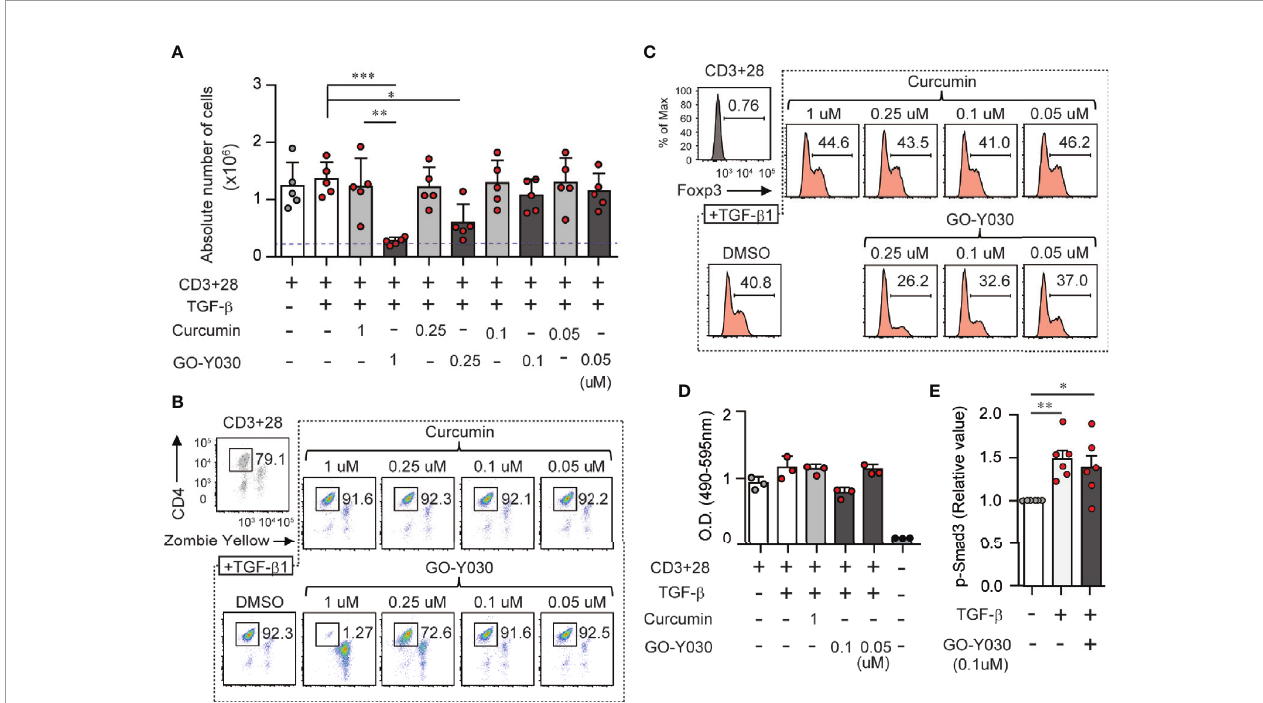
FIGURE 1 | GO-Y030 inhibits TGF- b -induced Foxp3 + Tregs. (A) Cell counts. Naïve splenic CD4 + T cells were cultured with or without 2 ng/ml TGF b and 1 µM curcumin or concentrations of GO-Y030 as indicated for a period of 3 days. The blue threshold shows the number of CD4 + T cells (0.25 × 10 6 cells) before culturing (0 h). (B, C) Frequency of Foxp3 + Tregs in the total CD4 + cell population. Naïve splenic CD4 + T cells were cultured with or without 2 ng/ml TGF b and 1 µM curcumin or concentrations of GO-Y030 as indicated for a period of 3 days. The data are representative of at least three independent experiments. (D) Relative live cell counts. Naïve splenic CD4 + T cells were cultured with or without 2 ng/ml TGF b and concentrations of GO-Y030 as indicated for 72 h, followed by the addition of the cell counting reagent. The horizontal bars represent the mean and standard deviation. (E) The relative value of phosphorylation of SMAD3. Splenic naïve CD4 + T cells were cultured in the presence or absence of 2 ng/ml TGF b or 0.1 µM GO-Y030 for 1 h. The absorbance at 450 nm in the absence of TGF b is set as “ 1. ” The horizontal bars represent the mean and standard deviation. The fi ndings were evaluated with a one-way analysis of variance (ANOVA) with post-hoc Tukey ’ s multiple comparisons test. *P< 0.05, **P < 0.01, ***P <